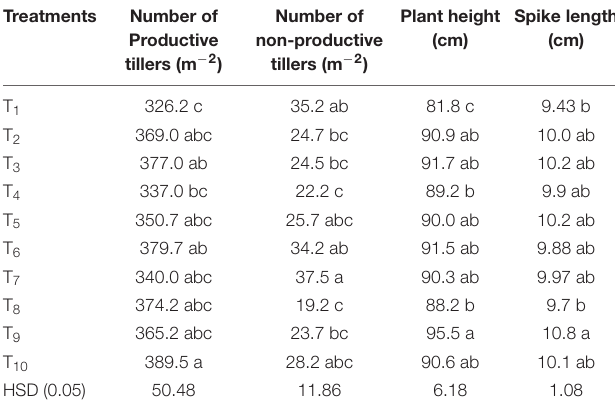
TABLE 1 | Influence of metribuzin alone and with adjuvants on number of productive tillers (m − 2 ), number of non-productive tillers (m − 2 ), plant height (cm), and number of grains per spike of wheat (average of 2 years’